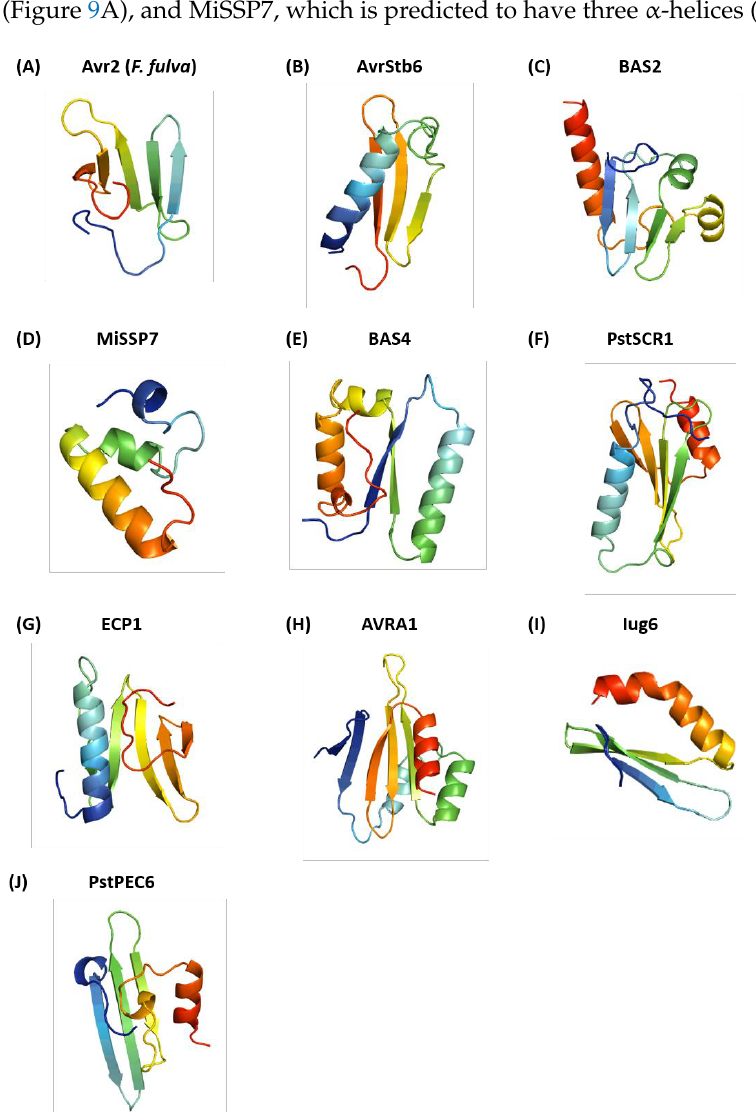
Figure 9. Rosetta ab initio models of structurally unconfirmed effector proteins obtained from PHI- base: Avr2 ( F. fulva ) ( A ), AvrStb6 ( B ), BAS2 ( C ), MiSSP7 ( D ), BAS4 ( E ), PstSCR1 ( F ), ECP1 ( G ), AVRA1 ( H ), Iug6 ( I ) and PstPEC6 ( J ). All models are represented with a rainbow colour scheme, from dark blue at the N-terminus to dark red at the